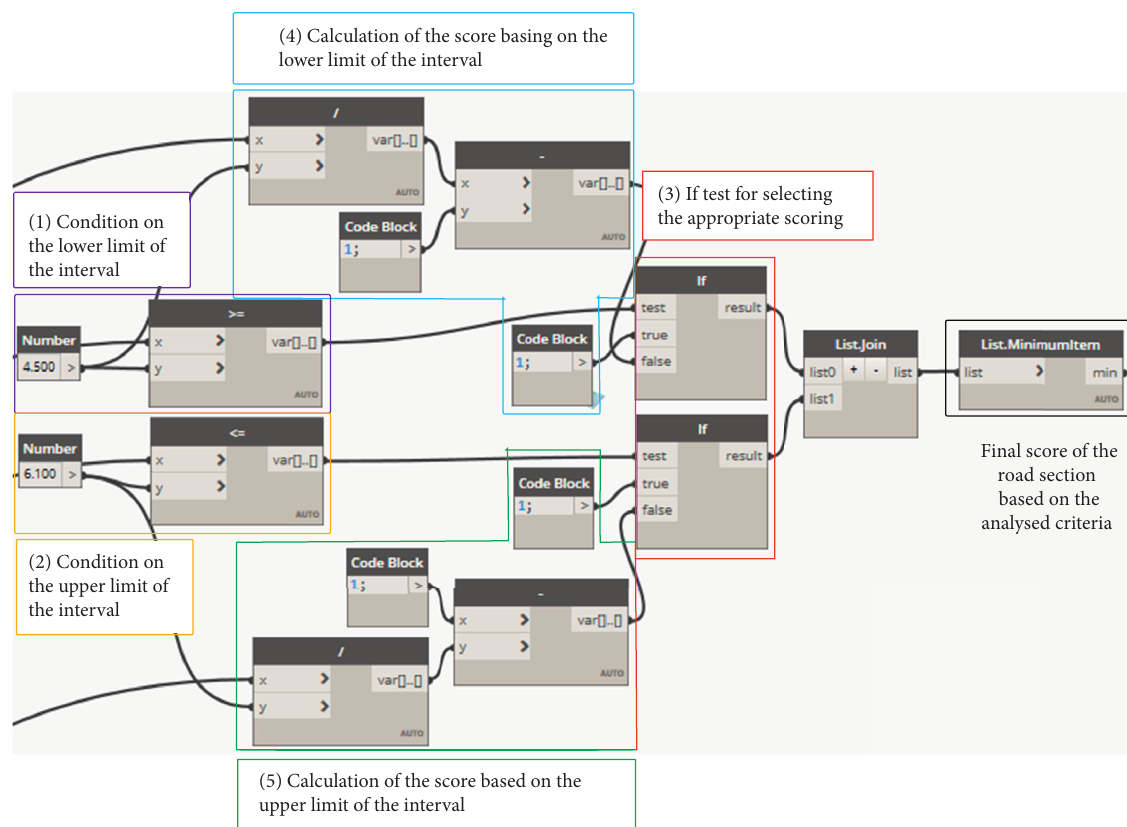
Figure 14: Bitumen content verification and scoring of the road